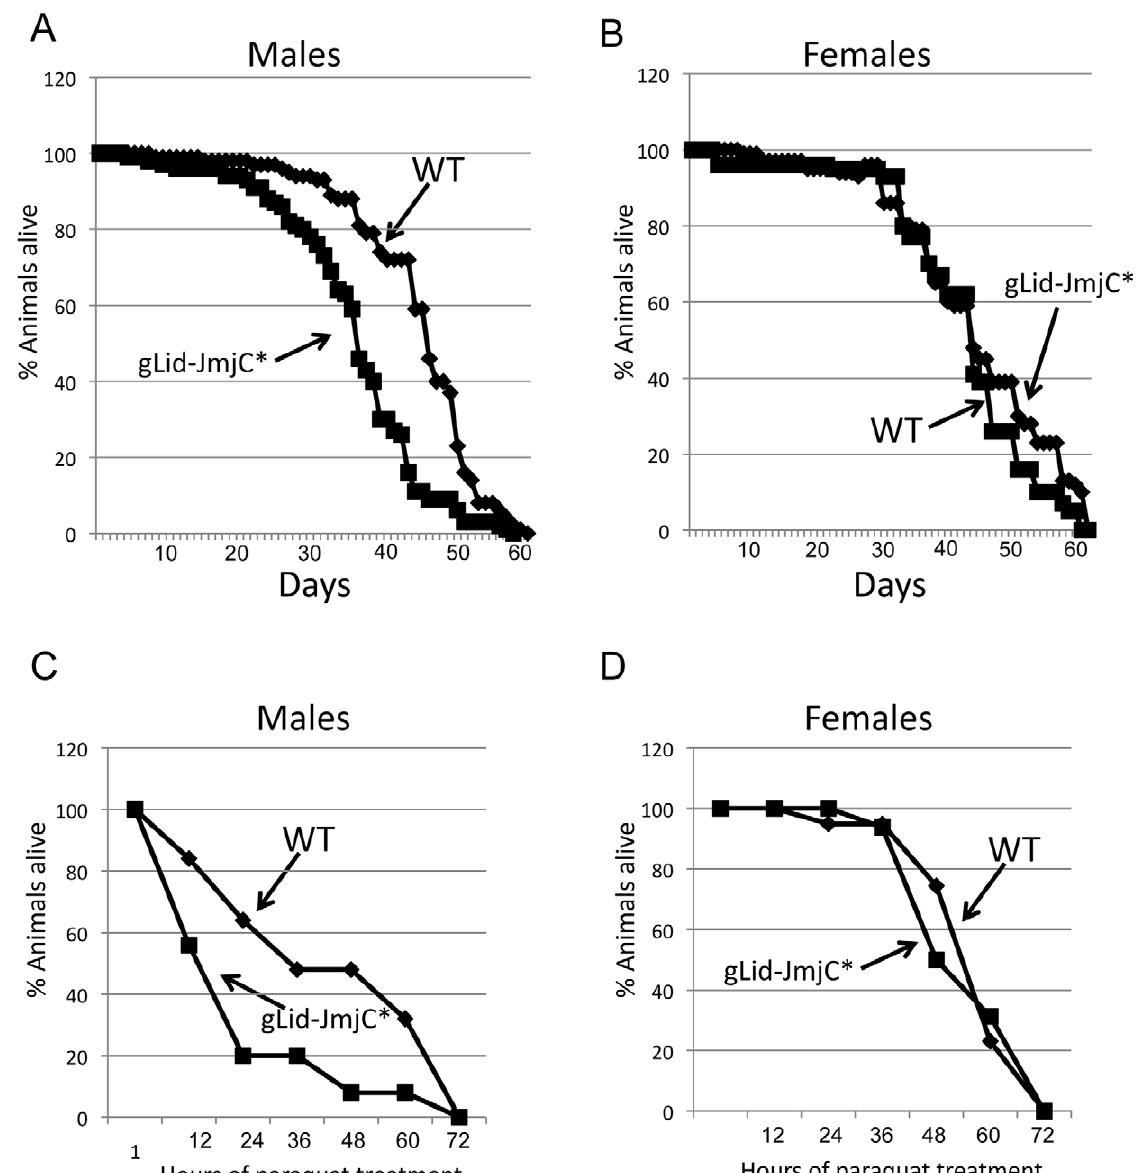
Figure 3. Demethylase inactive male flies are short-lived and sensitive to paraquat. (A, B) Lifespan of wildtype and demethylase inactive Lid males and females, respectively showing that males are short-lived whereas females have a normal lifespan. (C, D). Survival in response to 20 mM paraquat of wildtype and demethylase inactive males and females, respectively. Like lifespan, males are sensitive to paraquat whereas females are